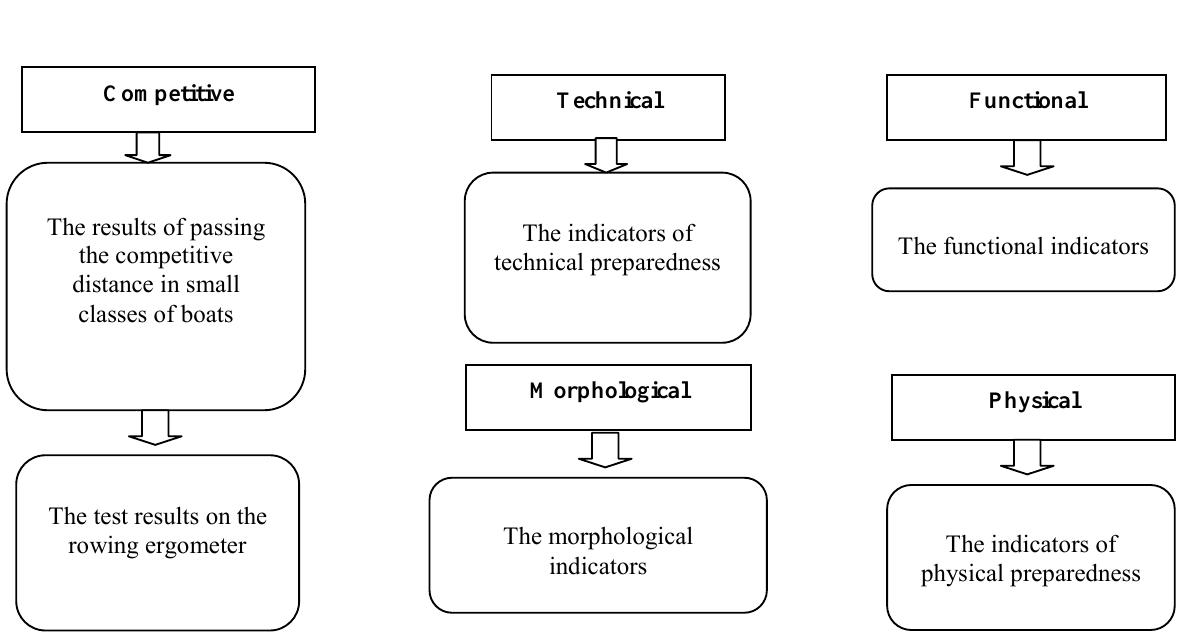
Fig. 1. Approaches to the selection of athletes in team boats and crews’ formation in foreign